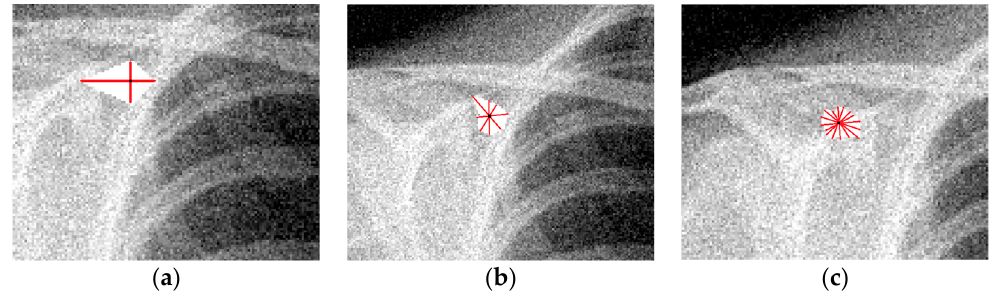
Figure 2. Examples of the detected regions obtained using the proposed method. ( a ) Quadrilateral region; ( b ) Octagonal region; ( c ) Hexadecagonal region.